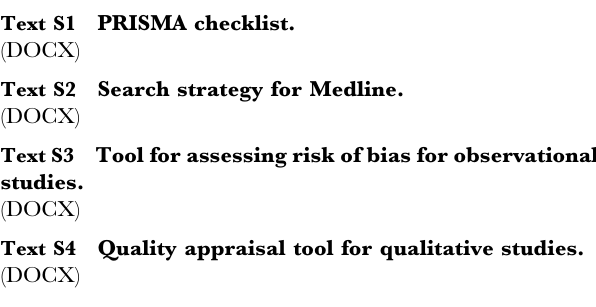
Table S1 Study designs, settings, findings, and risk of bias of included